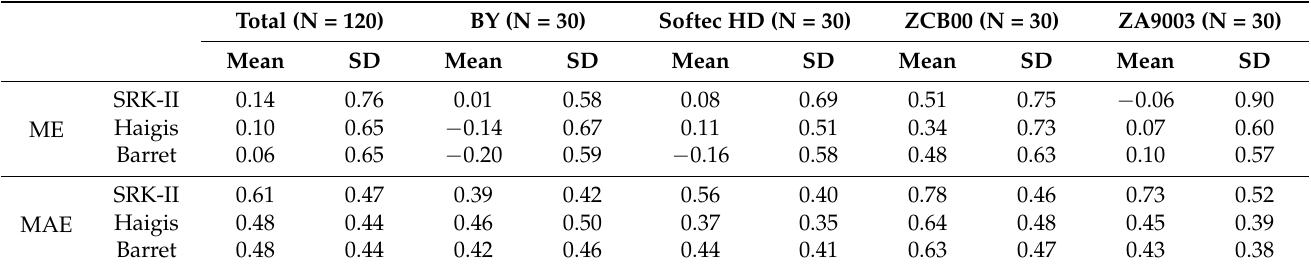
Table 2. Outcomes for each formula sorted by IOL